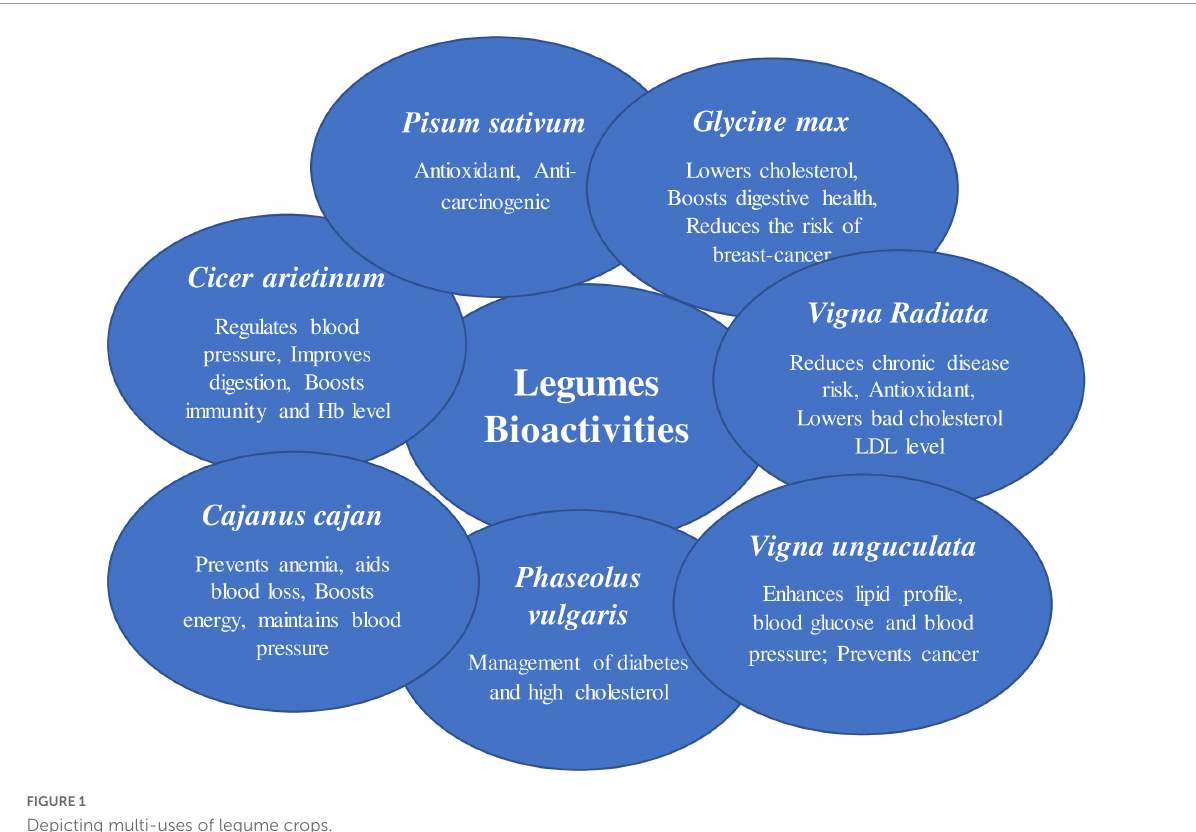
FIGURE1 Depicting multi-uses of legume